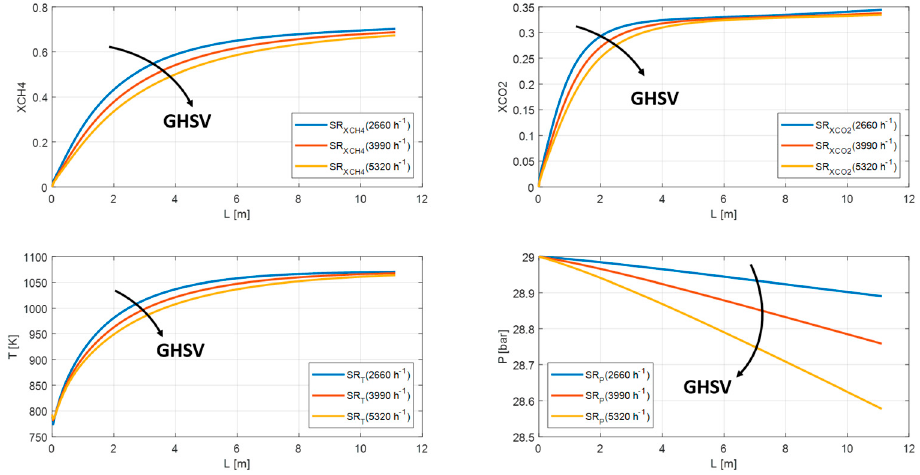
Figure 13. Methane conversion, carbon dioxide yield, temperature, and pressure profile in MR for GHSV = 2660, 3990, 5320 h − 1 .